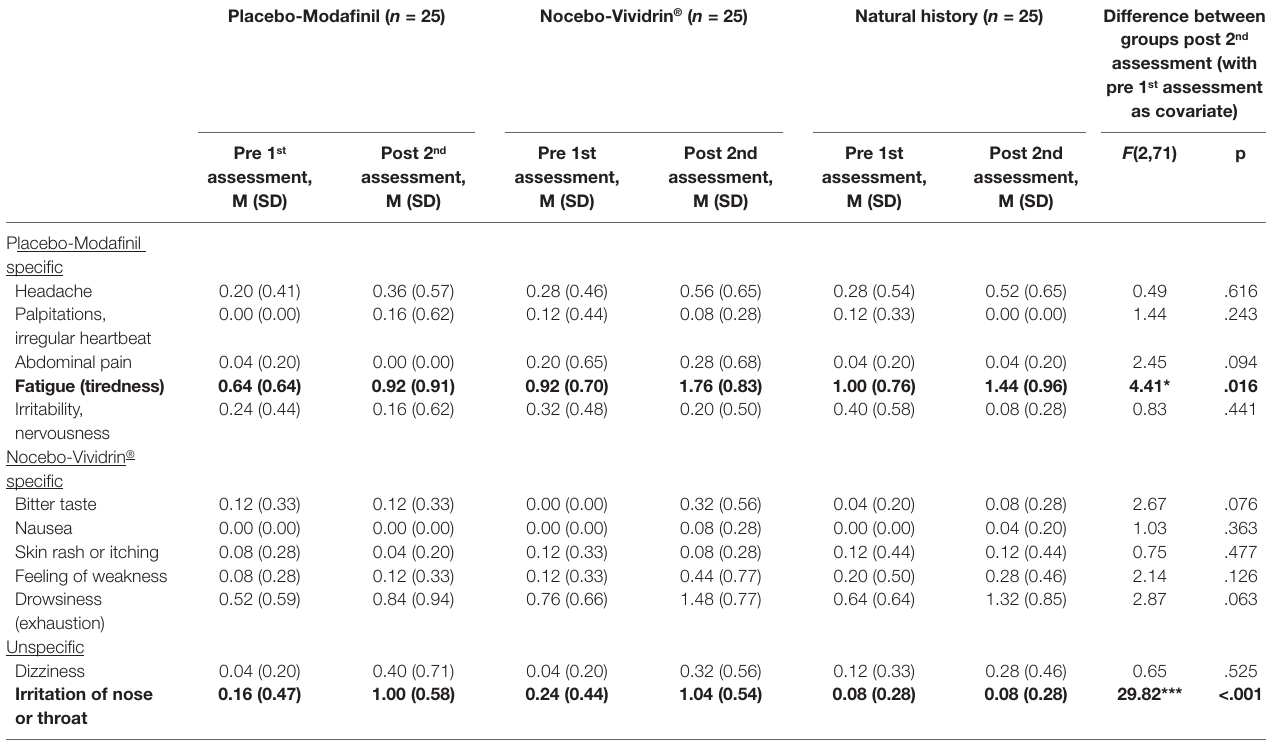
TABLE 3 | Intensity of the 12 selected GASE adverse symptom items before 1 st TAP assessment (baseline) and post 2 nd TAP assessment. Placebo-Modafinil ( n =